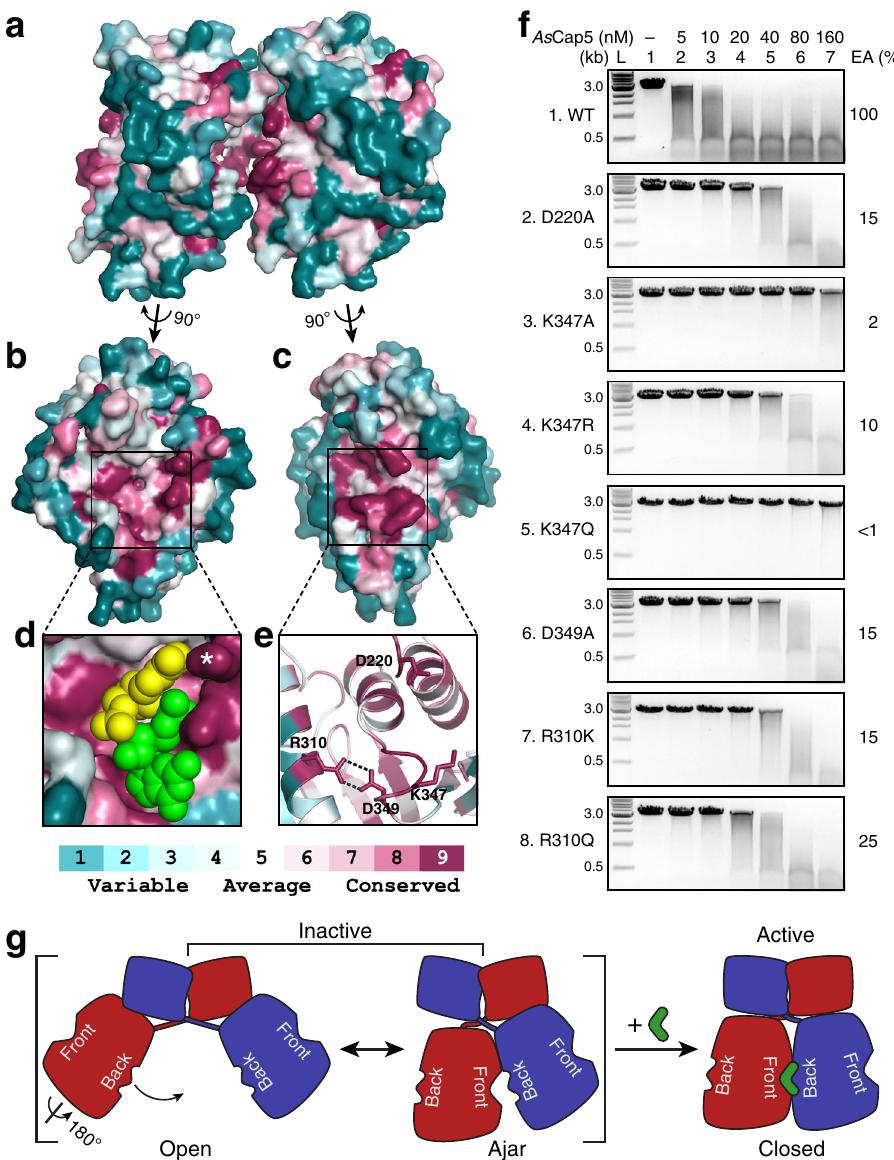
Fig. 5 Amino acid conservation of Cap5-SAVED and mutational studies. a Surface depiction of the structure of As Cap5-SAVED homodimer viewed from side. Two SAVED domains are colored based on the degree of amino acid conservation. b , c Conservation on the Front and Back of As Cap5-SAVED, respectively. d Closeup view of the ligand-binding pocket on the Front together with the docked 3 ′ ,2 ′ -cGAMP. 3 ′ ,2 ′ -cGAMP is in the sphere, with AMP and GMP moieties colored yellow and green, respectively. The side chain of R231 is marked with a white asterisk. e Cartoon depiction of the closeup view of the conserved residues on the Back. f DNA degradation assays by As Cap5 mutants. L, DNA ladder marked with the molecular weight in kilo-base pair; EA, estimated activity. Results are representative of three independent experiments. Source data are provided as a Source Data fi le. g Proposed mechanism of Cap5 activation via cGAMP-induced Back-to-Front stacking of two SAVED